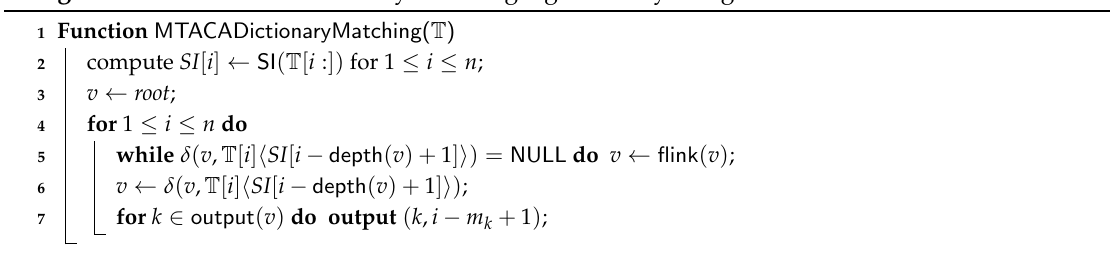
Algorithm 6: Permuted dictionary matching algorithm by using multi-track